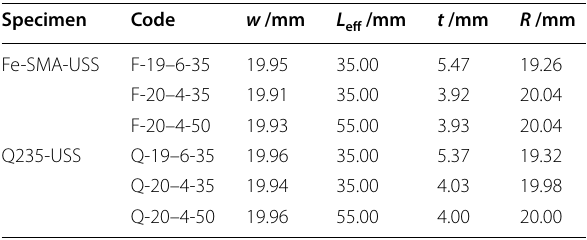
Table 2 Mechanical properties of different metals under monotonic